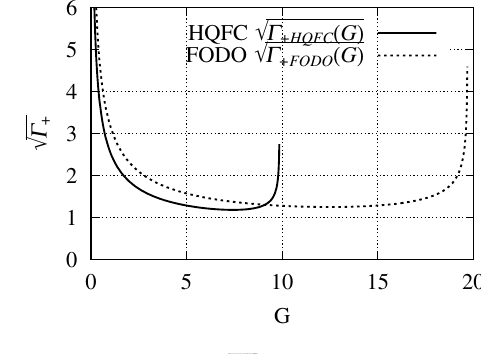
FIG. 2. Comparison of (cid:14)(cid:14)(cid:14)(cid:14)(cid:14)(cid:14)(cid:14) (cid:7) p between HQFC and